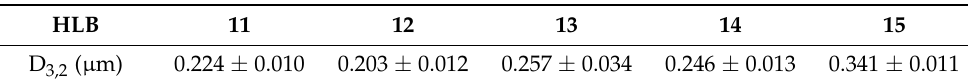
Table 1. Sauter diameter values for emulsions formulated with 5 wt% lemon oil as a function of surfactant-mixture HLBs.